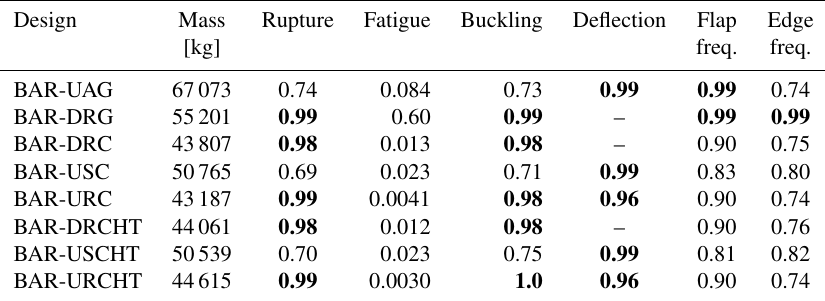
Table 6. Final mass and state of design constraints for optimized blade designs. Constraint index (unitless) values expressed as defined in Eqs. (8)–(13), with limiting constraints denoted with bold font. Design Mass Rupture Fatigue Buckling Deflection Flap Edge [ kg ] freq. freq. BAR-UAG